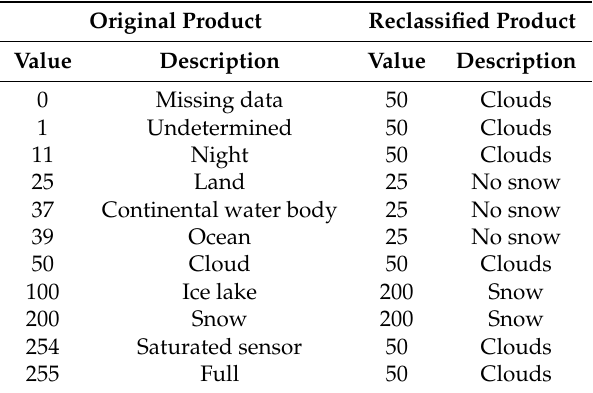
Table 2. MOD10A2 original and reclassified